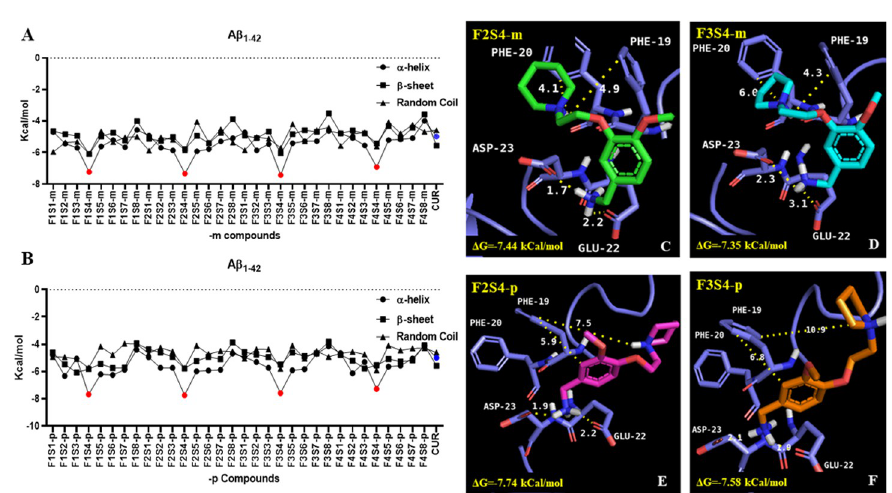
Fig 2. Docking results for designed compounds towards three A β 1–42 monomer secondary conformations ( α - helix, β -sheet, and random coil). Free energy values obtained for; A) 1,3 substituted (-meta) compounds, B) 1,4 substituted (-para) compounds. Methanamine (S4) bearing compounds in both substitution positions (red points in chart) containing piperidine (F2) and pyrrolidine (F3) were the best compounds. Binding analysis of containing methanamine compounds (S4) and A β 1–42 : C) F2S4-p, D) F3S4-m, E) F2S4-p, F) F3S4-p. All compounds were able to place one of amino groups in an interaction with Asp 23 and Glu 22 and interact with aromatic residues (Phe20) by π - π stackings.